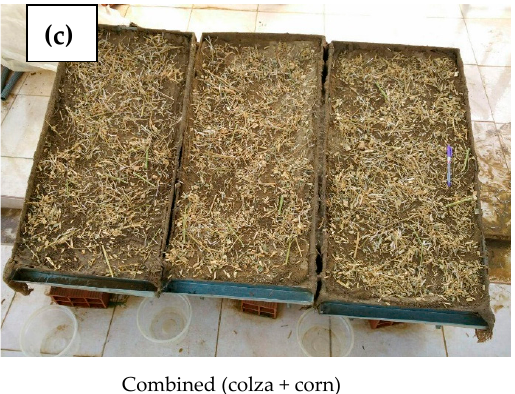
Figure 2. A view of applied straw mulches of colza ( a ), corn ( b ) and combined colza and corn ( c ). Table 1. Soil erosion results under di ff erent soil moisture conditions and straw mulch covers. C, control; M, mulched; ASM%, antecedent soil moisture; R, runo ff ; SC, sediment concentration; SL, soil